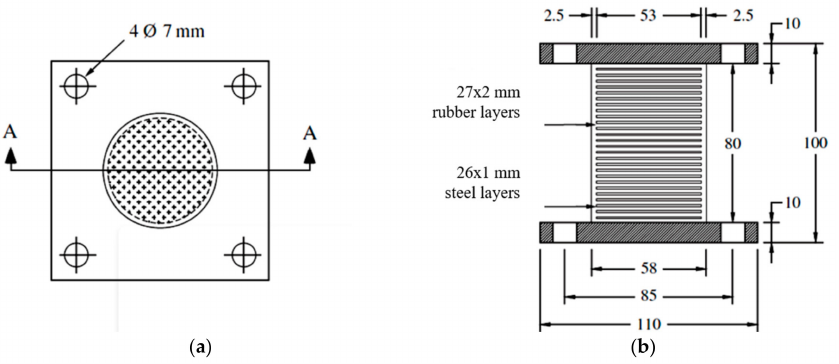
Figure 4. HDRB isolator: ( a ) plant view, ( b ) section